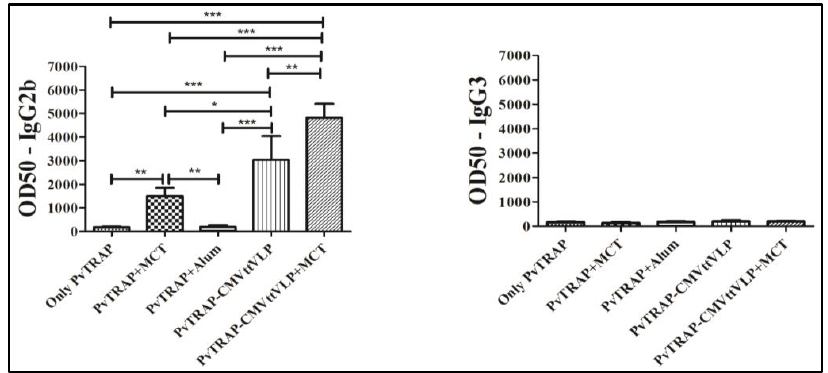
Figure 5. Analysis of relevant subclasses of IgG (IgG1, IgG2a, IgG2b, IgG3). In order to check the prevalent subclass of IgG, enzyme-linked immunosorbent assay (ELISA) was done using samples of all vaccinated groups on Day 35 (one week before challenge). The results were analysed using GraphPad Prism software applied to assess the means of five groups by one-way analysis of variance (one-way ANOVA). The values observed in the negative control group were subtracted from the titres of the other experimental groups. Note: *** = p value < 0.0001; ** = p value < 0.001; * = p value < 0.01.